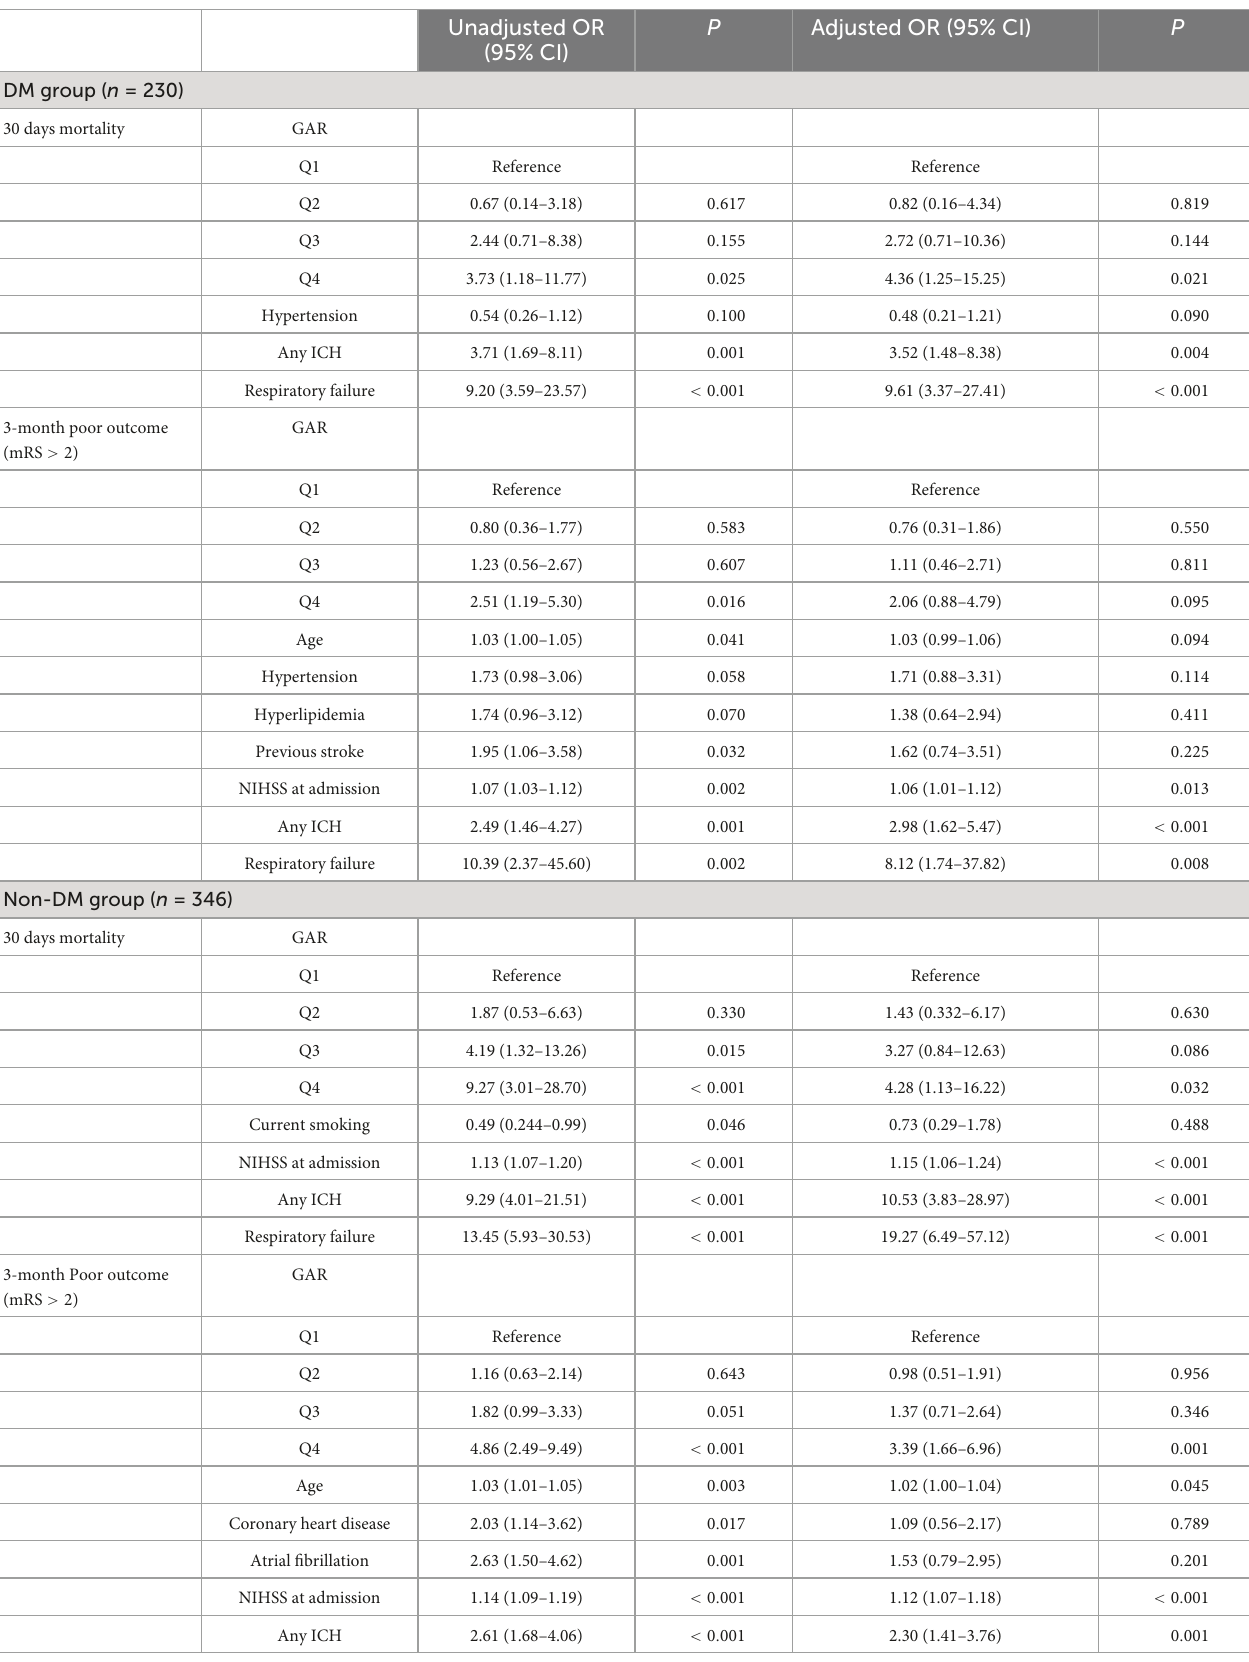
TABLE 4 Outcome Complications by Logistic Regression Model [ORs (95% CIs) of outcome measures adjusted for GAR quartiles].